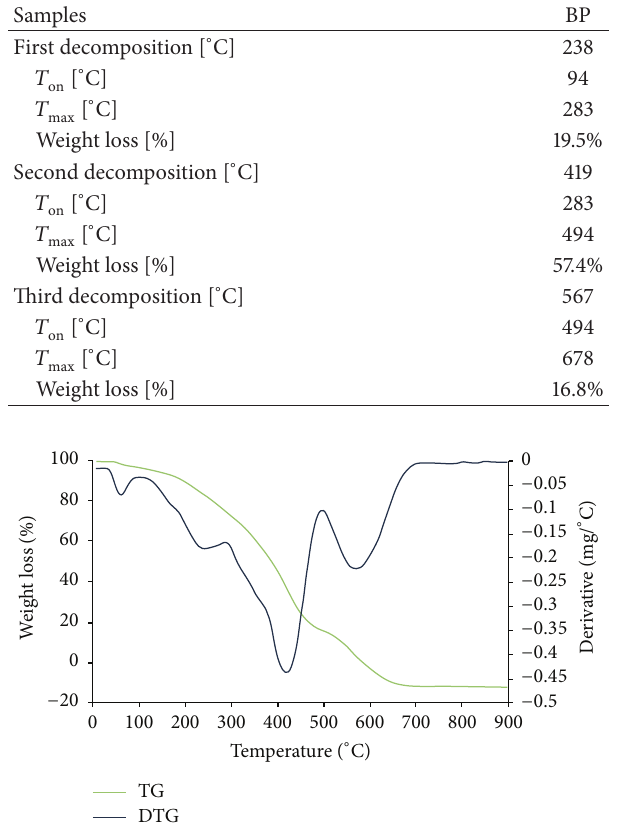
Figure 3: Thermogram (TG) and derivative weight loss (DTG) of BP samples.